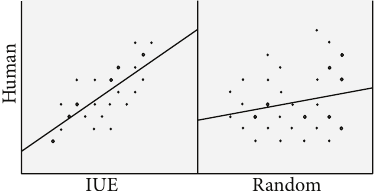
Figure 5: Visualizing the correlation between the IUE tool, random baseline, and human annotators for the task of detecting homepage- to-webpage structural layout